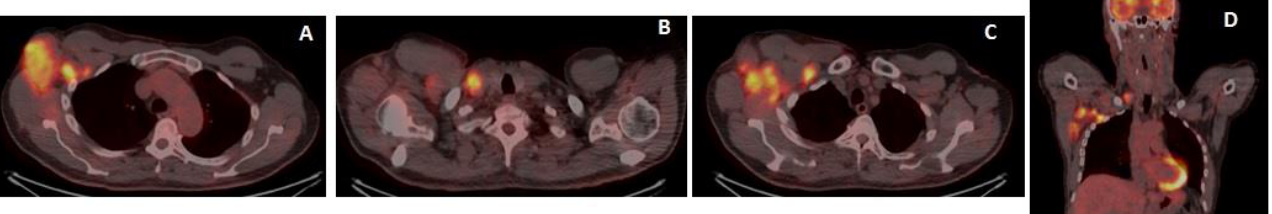
Figure 4. Lymphoma cells are positive for T-cell markers: CD3 ( A ), CD2 ( B ) and CD4 ( C ). They are also diffusely and strongly positive for CD30, with a membranous and dot-like pattern ( D ). ALK protein was negative (not shown).